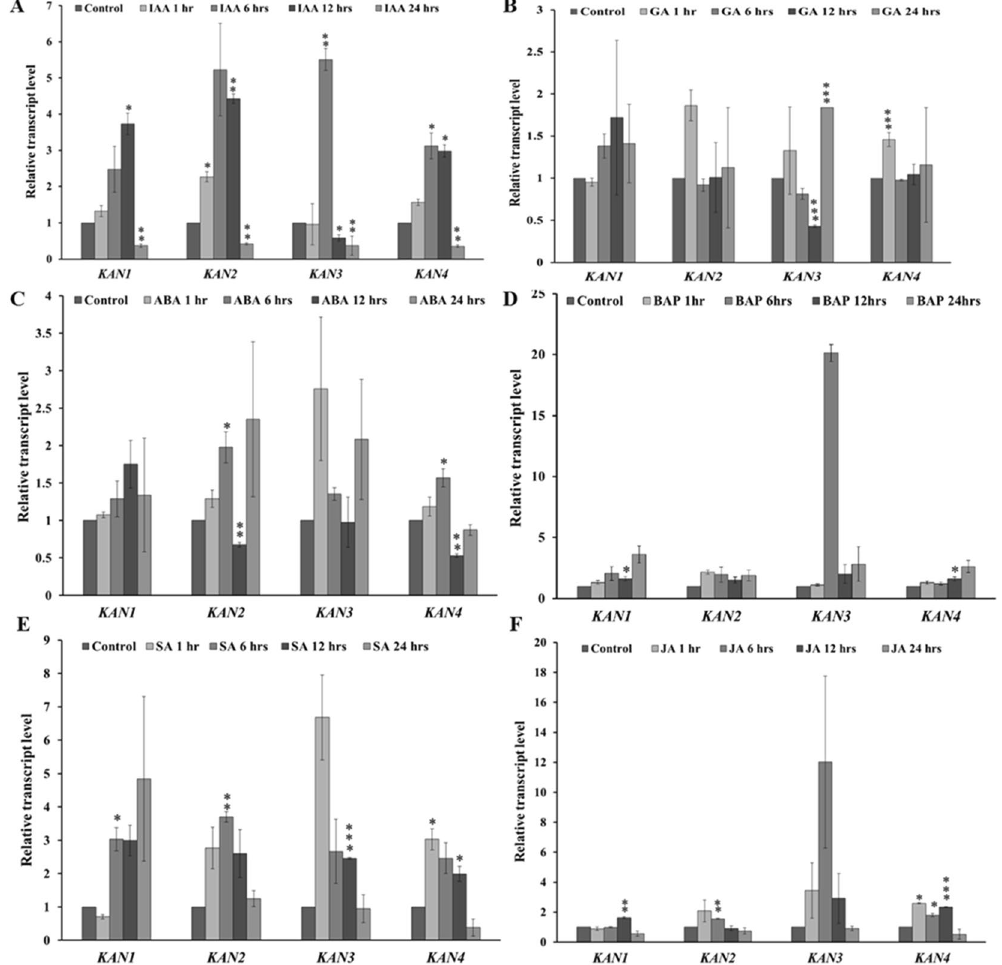
Figure 6. Phytohormones affect the expression level of KAN genes. The expression of KAN genes in Arabidopsis roots was checked at 1, 6, 12 and 24 hrs of the treatment with ( A ) 10 µ M IAA, ( B ) 10 µ M GA, ( C ) 10 µ M ABA, ( D ) 20 µ M JA, ( E ) and 100 µ M SA. The control indicates without hormone treatment in each case. Error bars indicate ± SE of two independent biological experiments. One-way ANOVA was performed. Statistically significant differences are indicated as, * for P < 0.05, ** for P < 0.01 and *** for P <